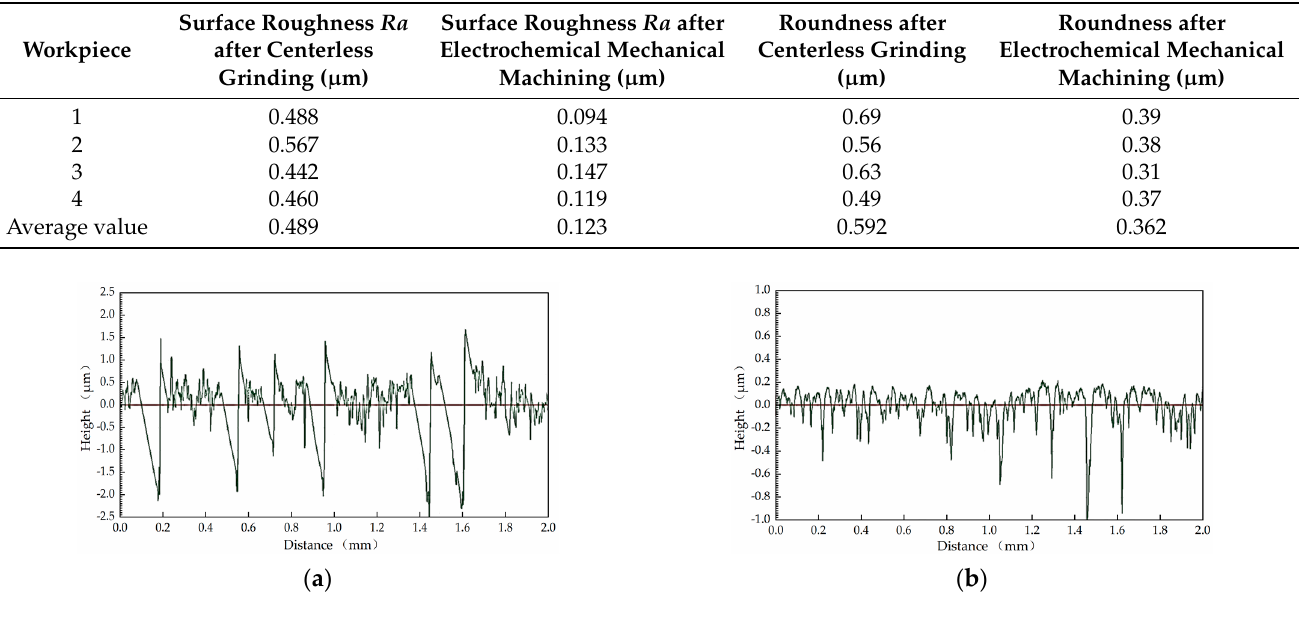
Figure 11. Surface roughness profile of workpiece after machining: ( a ) centerless grinding; ( b ) elec- trochemical mechanical